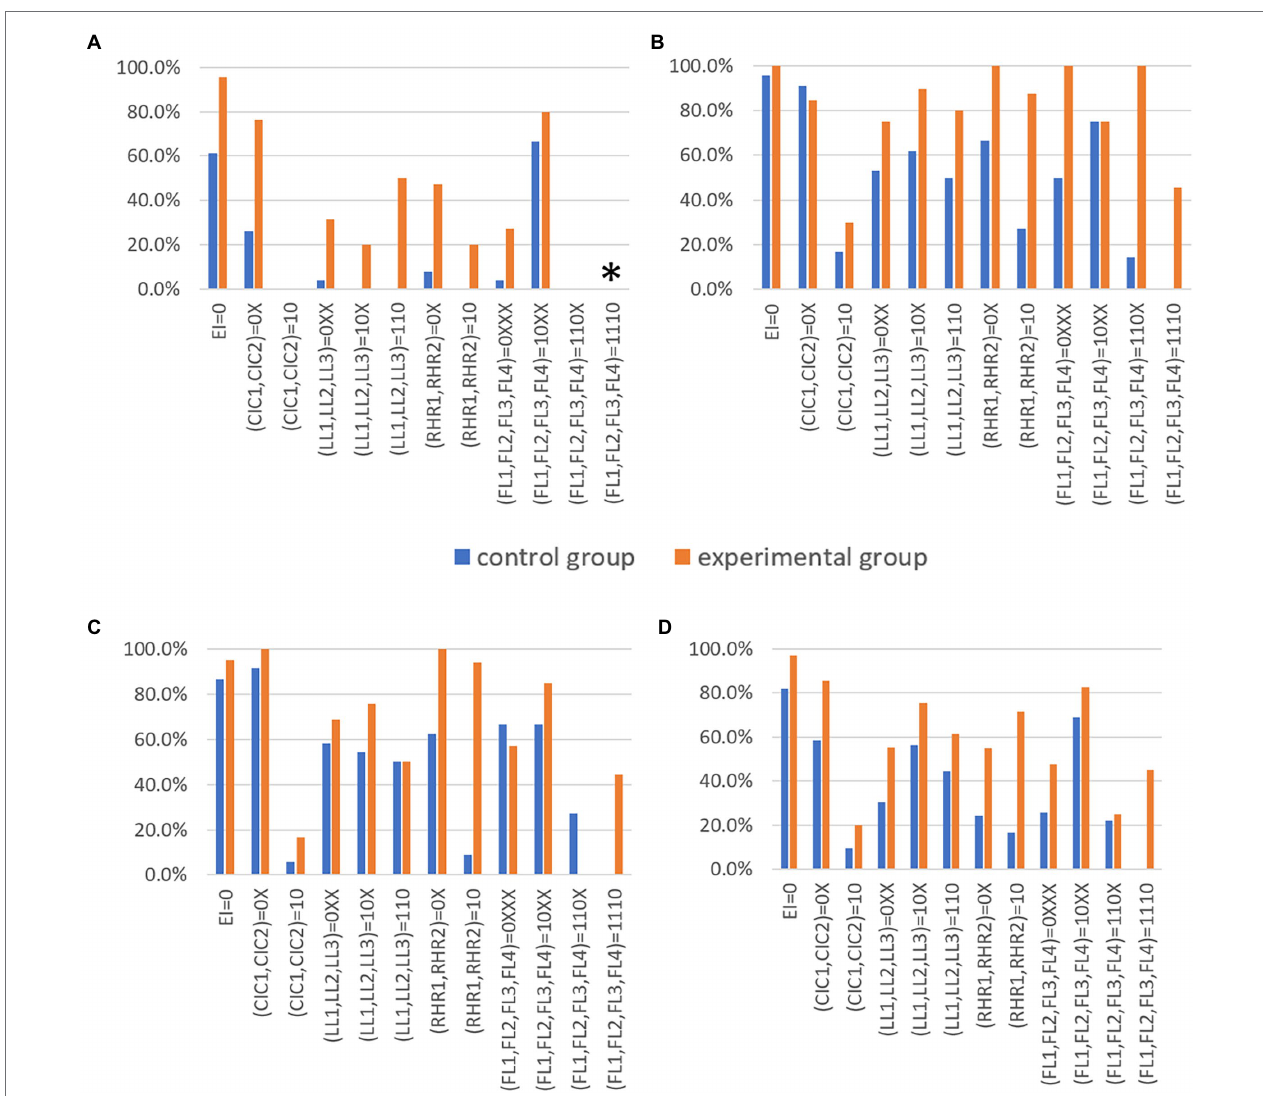
FIGURE 10 | Comparison of the achievement rate of 12 target attribute mastery patterns between the control and experimental groups in schools S1, S2, and S3. (A) is a bar graph comparing the achievement rate of 12 target levels between the control and experimental groups of participants at School S1. The achievement rate of (FL1,FL2,FL3,FL4) = (1110) was 0 because no student had mastered the attributive FL3, so no students should regard (FL1,FL2,FL3,FL4) = (1110) as the target attribute mastery. (B,C) show seniors at Schools S2 and S3. (D) Shows a bar comparison of the average achievement rate of 12 target levels between the control and experimental groups in Schools S1, S2, and